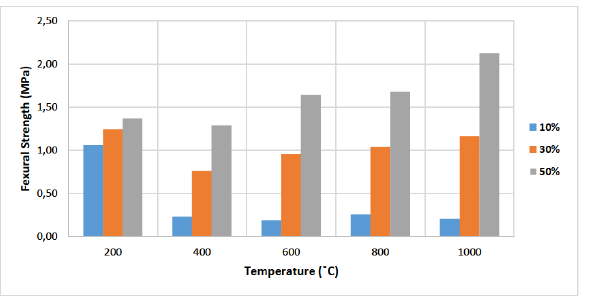
Figure 15: Evolution of Flexural strength of geopolymer foams vs. heating